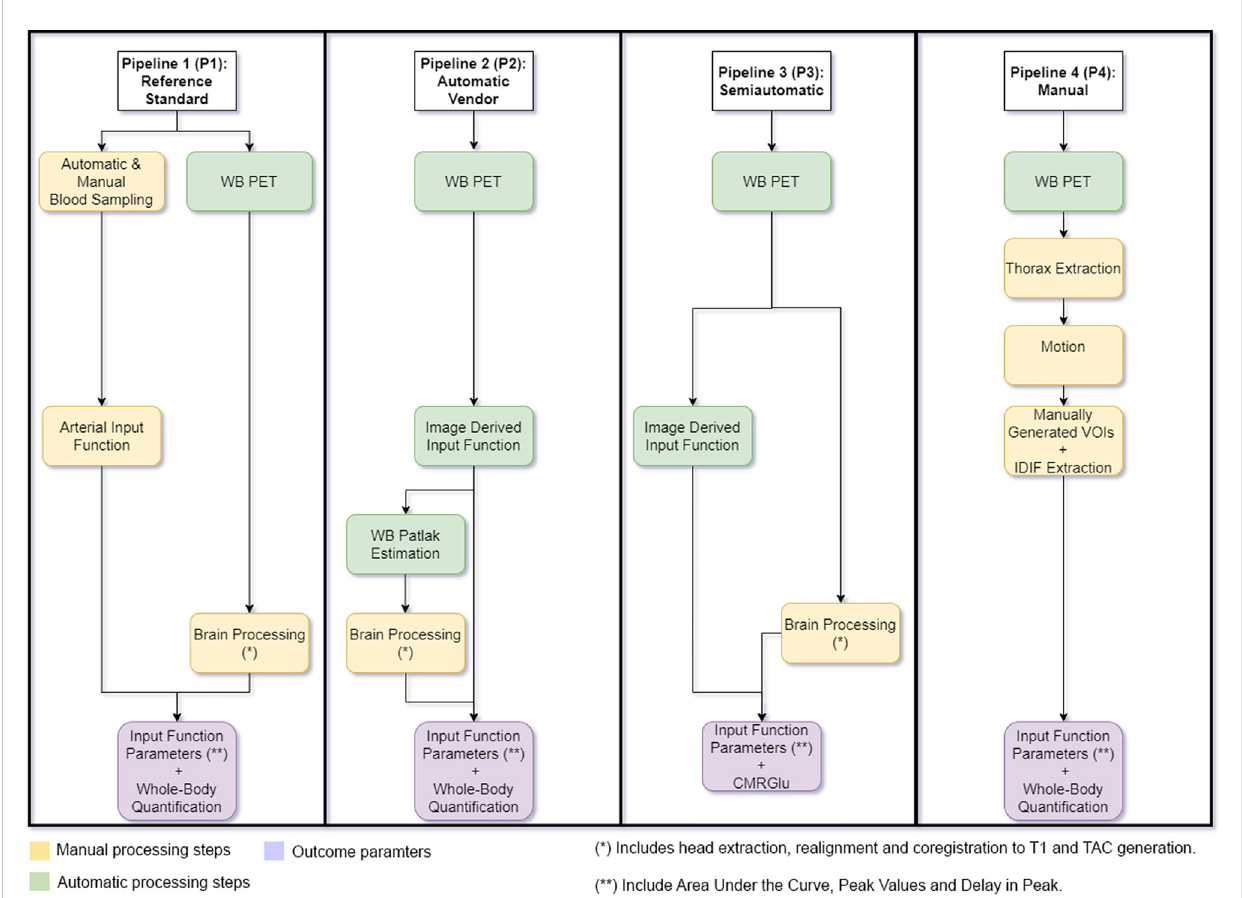
FIGURE 1 Graphical Overview of each processing pipeline used. Pipeline 1 represents the reference standard where arterial blood samples were used to generate cerebral metabolic rate of glucose (CMRGlu) values. Pipeline 2 represents the vendor implemented pipeline including image derived input function extraction and Patlak slope and intercept generation. CMRGlu was subsequently estimated manually. Pipeline 3 shows the semiautomatic processing pipeline where the automatic vendor derived input function was used to manually process CMRGlu estimates (the IDIF here is the same as in P2). Pipeline 4 includes manually placed volumes of interest used to extract the image derived input function. Whole-body images were then corrected for movement using a least squares approach and a 6 parameter rigid body spatial transformation as implemented in SPM12 and further calculation were done on both movement corrected data and compared to the arterial input function. Outcome estimates from each pipeline were compared to each otherto assesssimilarity.Yellowboxes represent all manual processing steps, Green boxesrepresent allautomatic vendor processing steps and purple signi fi es the pipeline outcome